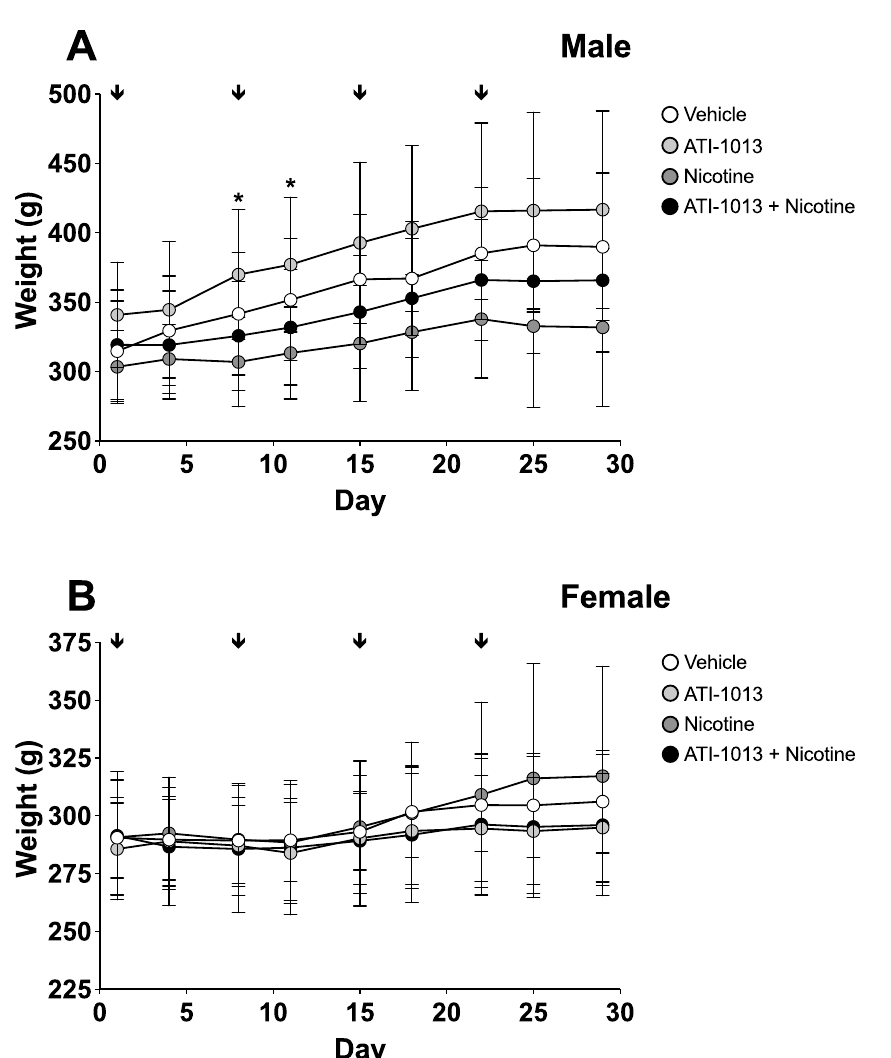
Fig 8. Body weight over time in toxicology study. Male (n = 8/group, Panel A) and female (n = 8/group, Panel B) SD rats were divided into four groups. Animals were implanted with osmotic pumps delivering a continuous dose of nicotine (1 mg/kg/day) or vehicle throughout the study period. ATI-1013 (200 mg/kg, i.v.) was delivered weekly. Group 1 received saline (open circles), group 2 received nicotine only (dark grey circles), group 3 received ATI-1013 (light grey circles), and group 4 received ATI-1013 and nicotine (closed circles). Arrows indicate times when ATI-1013 was administered. Mean ± SD. � p < 0.05 ATI-1013 group compared to nicotine alone